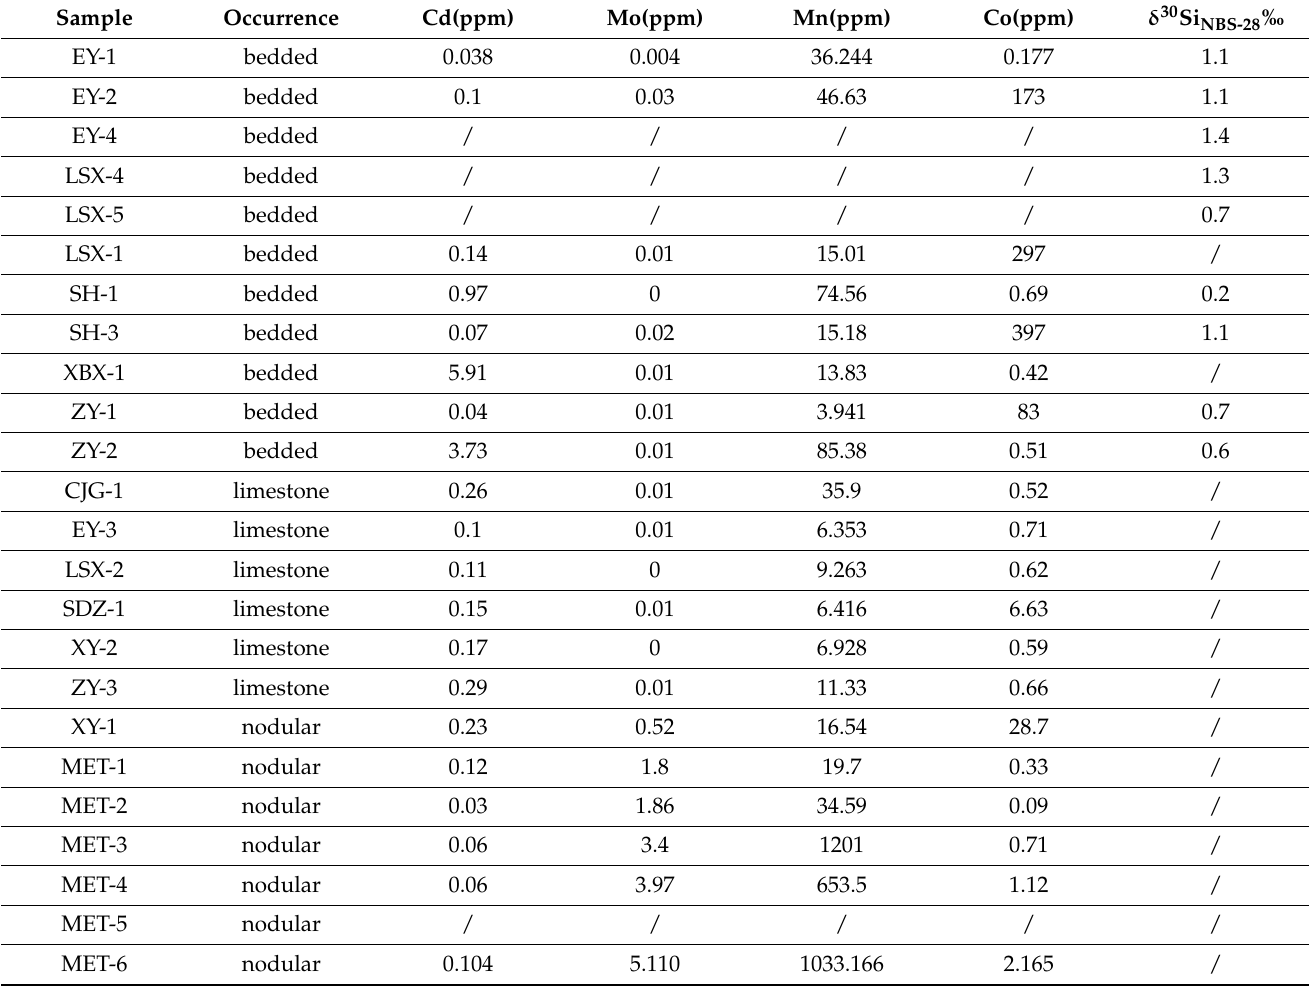
Table 2. Trace elements and stable silicon isotope compositions of the Maokou cherts and limestones in the Sichuan Basin.